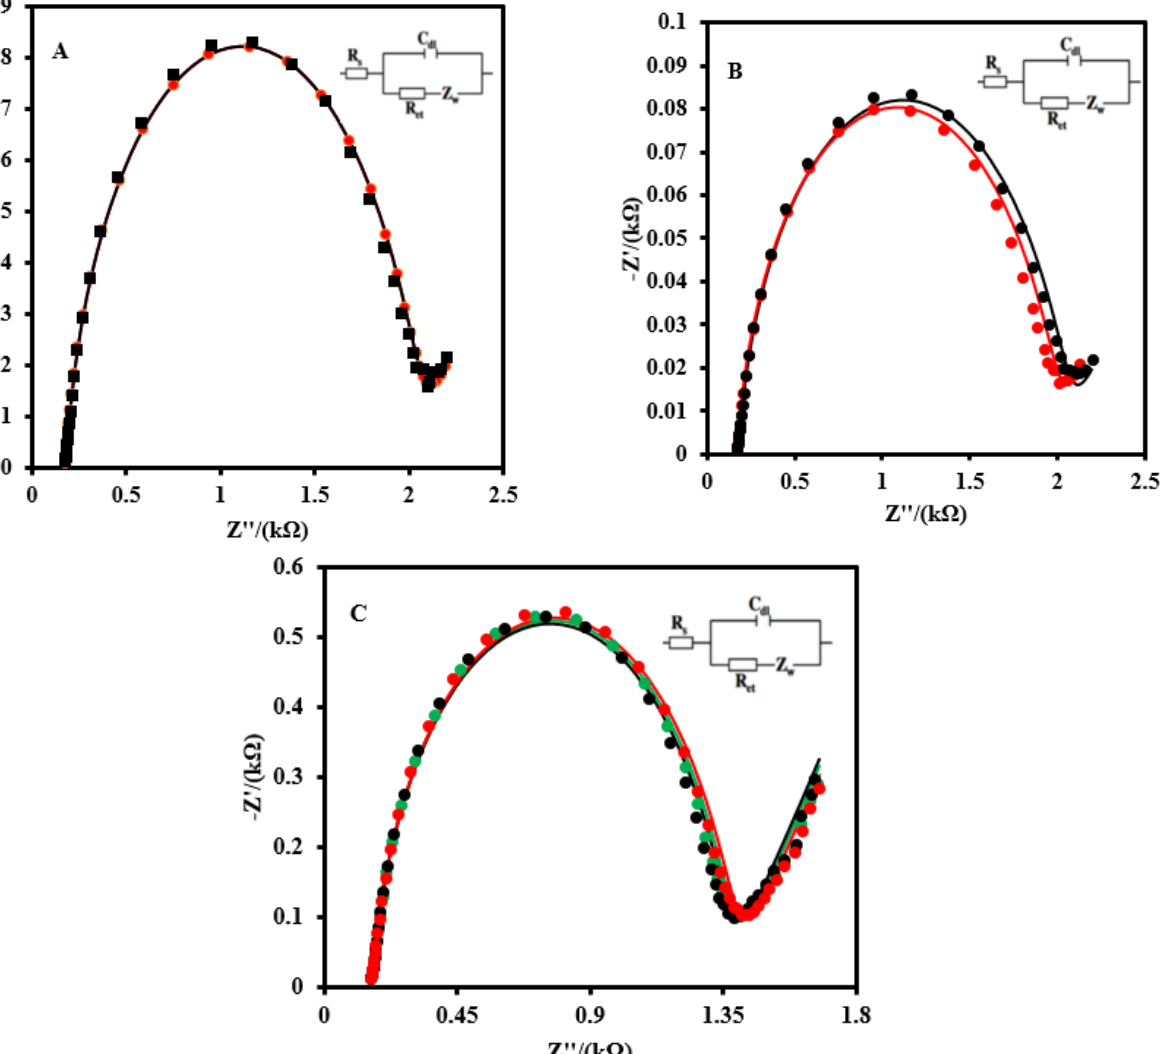
Figure 5. ( A ) EIS of the CSPE/CNF–AuNP/Aptamer to 2 nM SARS-CoV-2 RBD in the absence (black curve) and presence of 200 nM of HIgG, HIgA, HIgM, and HSA (red curve). ( B ) The EIS of the CSPE/CNF–AuNP/Aptamer to 2 nM of SARS-CoV-2 RBD in the absence (red curve) and presence of 200 nM of HA, and N from an influenza A virus (blue curve). ( C ) The stability of the CSPE/CNF–AuNP/Aptamer on the different days (First day: green curve; Seventh day: black curve; Fourteenth day: red curve). EIS spectrums were recorded in 5.0 mM Fe(CN) 63 − /4 − solution (0.1M PBS, pH 7.4). The equivalent electric circuit is compatible with the Nyquist diagrams. R s : Solution resistance; R ct : Charge transfer resistance; C dl : Double layer capacitance; Z w : Warburg impedance. The AC amplitude was 10 mV, DC potential was 0.13 V, and the frequency range was 100 kHz − 0.1 Hz.